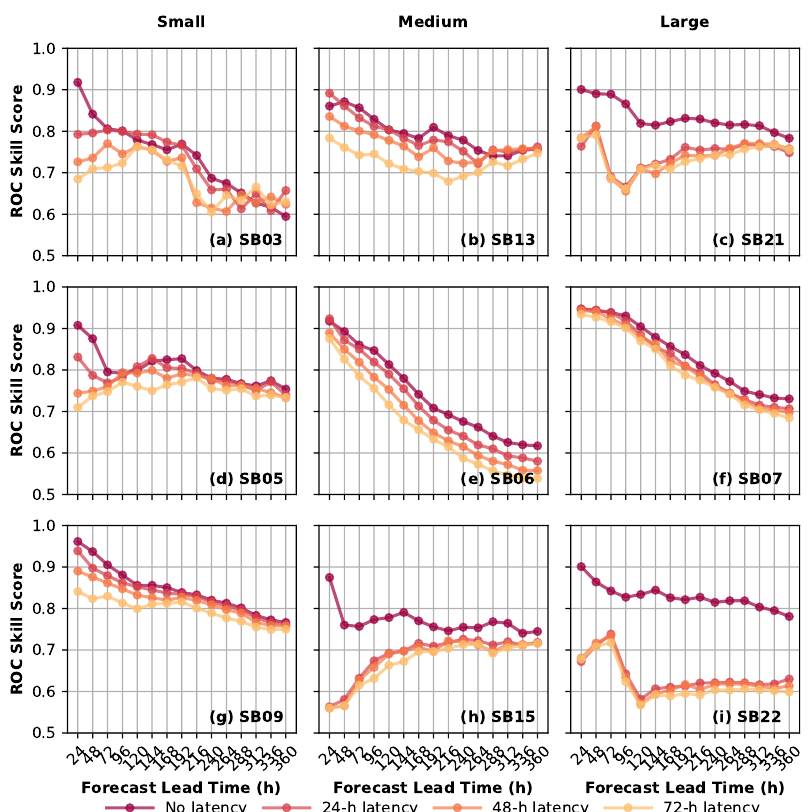
Figure 5. ROC skill score probabilistic streamflow forecast for the ECMWF ensemble model for a 1 d update and different latencies (0 h, 24 h, 48 h, and 72 h latencies) and drainage areas: small sub-basins (left column), medium sub-basins (center column), and larger sub-basins (right column), for streamflow with a probability level of 0.9.